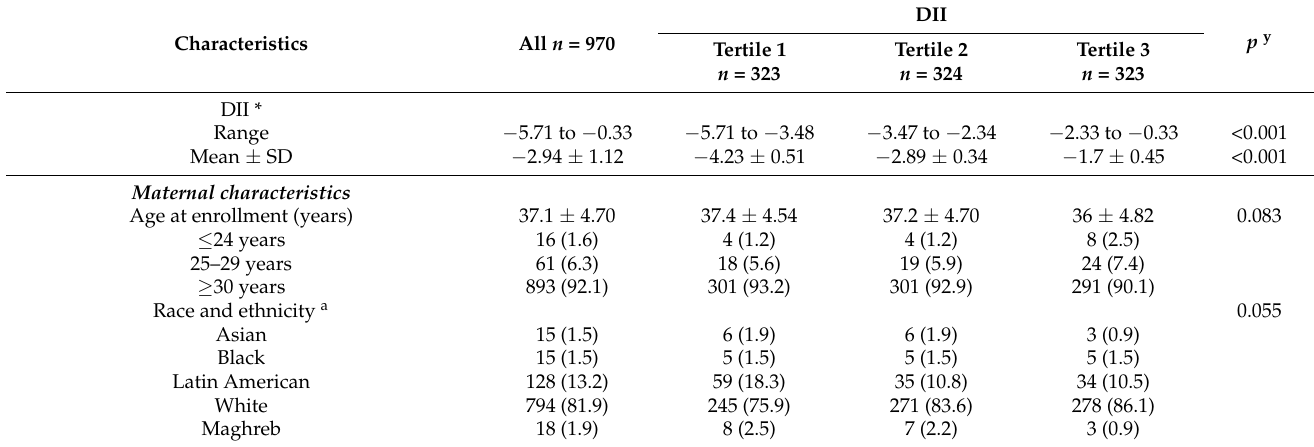
Table 1. Baseline characteristics of study participants according to DII score